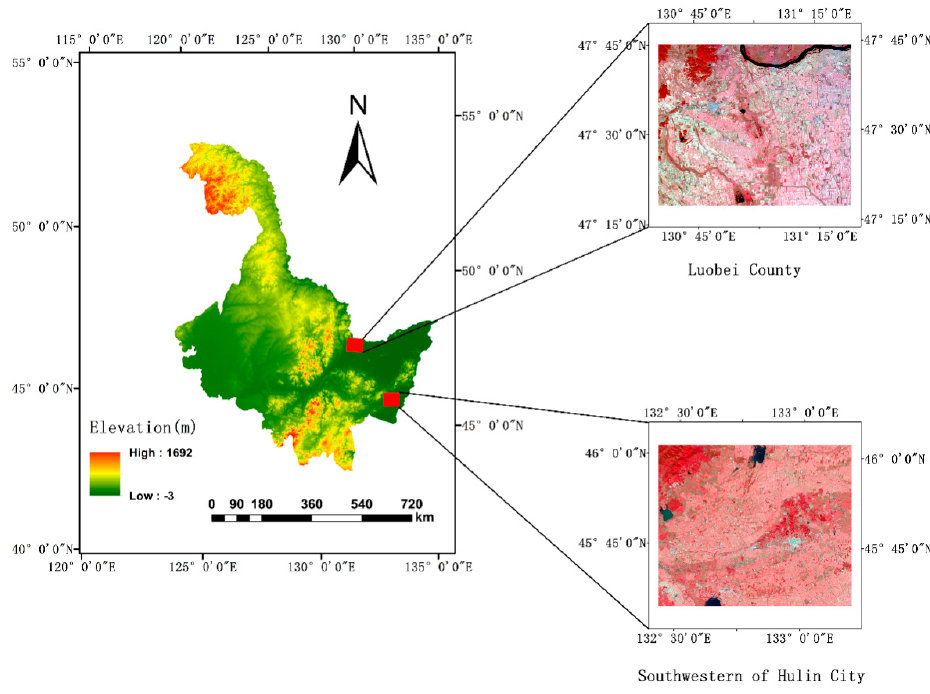
Figure 1. Study area, including the Luobei County and the southwest of Hulin City. Both are in the